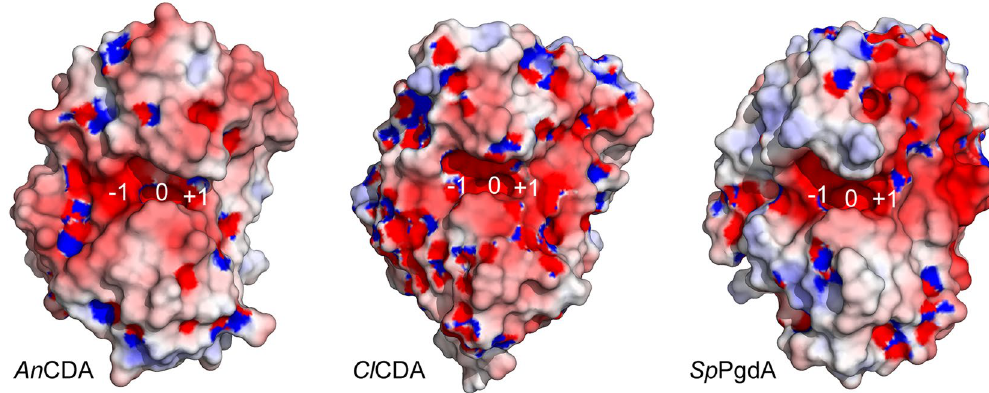
Figure 8. Comparison of charge distributions in deacetylases. The pictures show the surfaces of An CDA, Cl CDA (PDB id: 2IW0 9 ), and Sp PgdA (PDB id: 2C1G 15 ) coloured by charge calculated using the ABPS 52 plugin in PyMol. Red represents negative charge and blue represents positive charge; solvent accessible surface potentials were set to − 5 and 5 kT/e. The approximate locations of subsites − 1, 0, and + 1 are